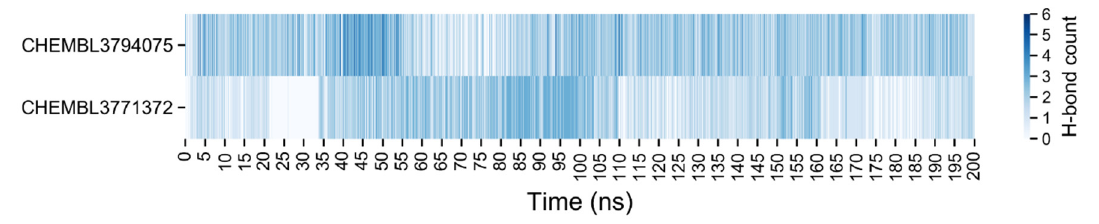
Figure 18. Number of hydrogen bonds between the P20S and the ligands, the top from the CHEMBL3771372 and the bottom from the CHEMBL3794075. A detailed plot is shown in Supporting Figures S10 and S11.